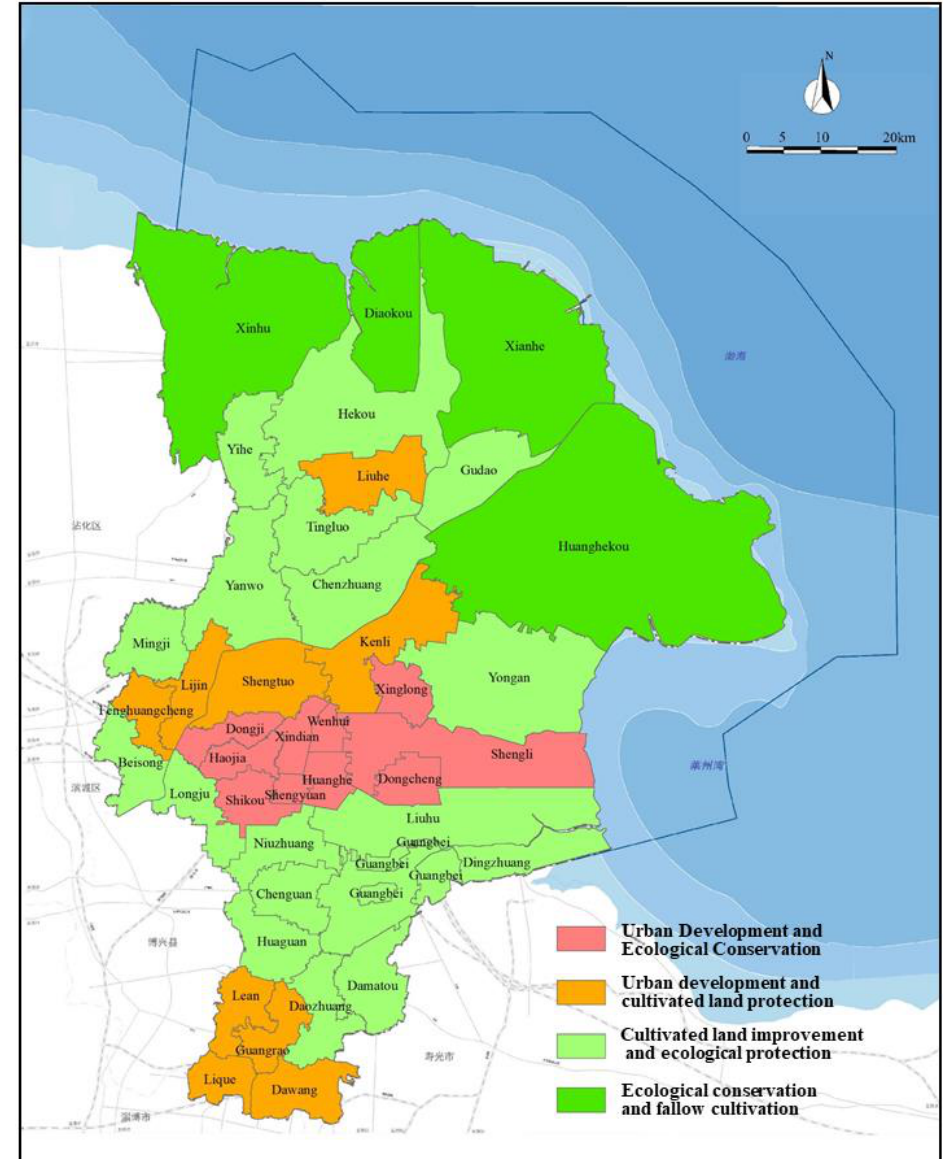
Figure 4. Functional zoning map of land comprehensive consolidation in Dongying City.